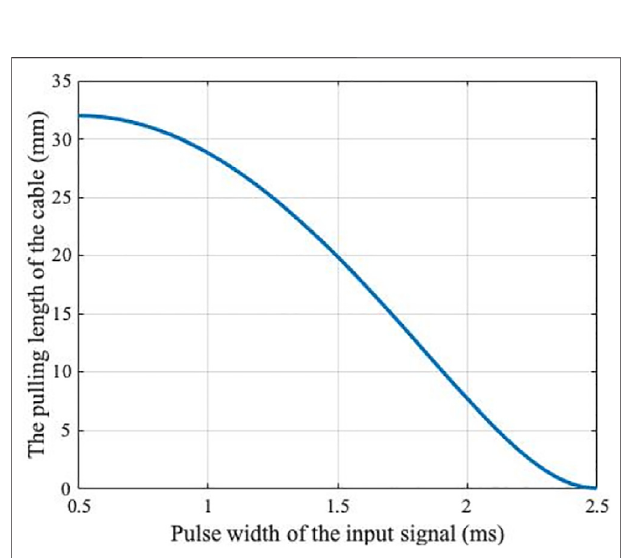
FIGURE 2 | The relationship between the parameter of the servomotor and the pulling length of the cable.